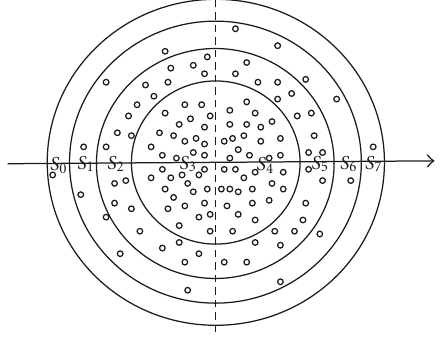
Figure 5: Partition of a 128 point 2-dimensional Gaussian code- book into 8